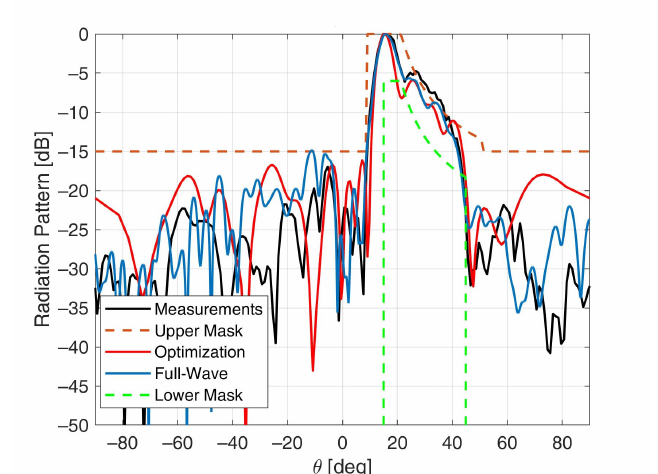
Figure 10. Radiation patterns in the E-plane at 30